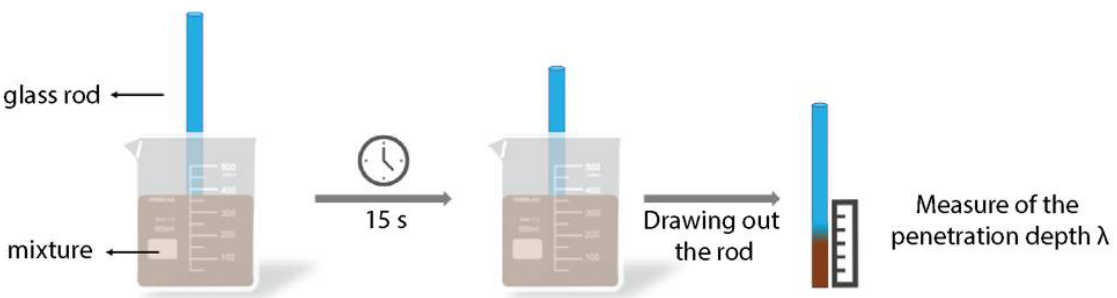
Figure 2. Schematics of the method for measuring the penetration depth λ .